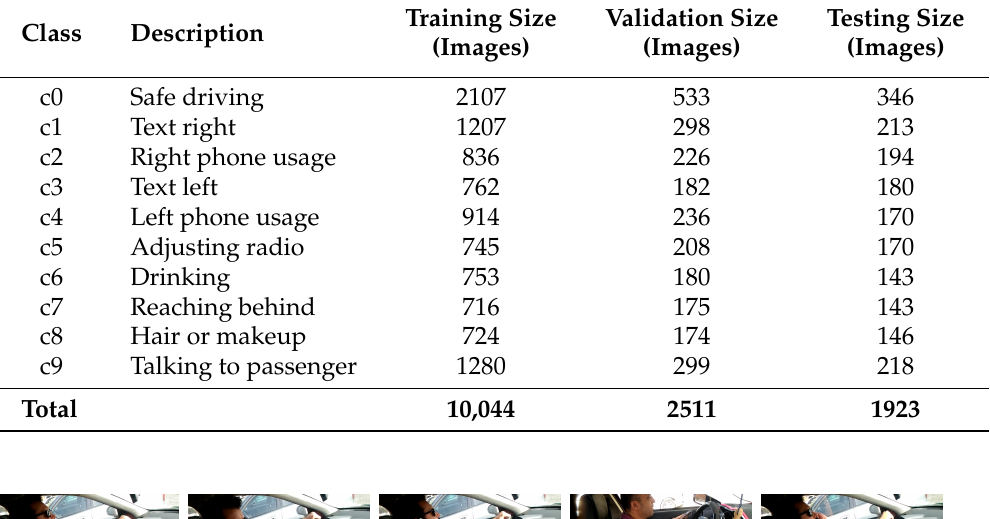
Table 2. Summary of AUC-DDD.